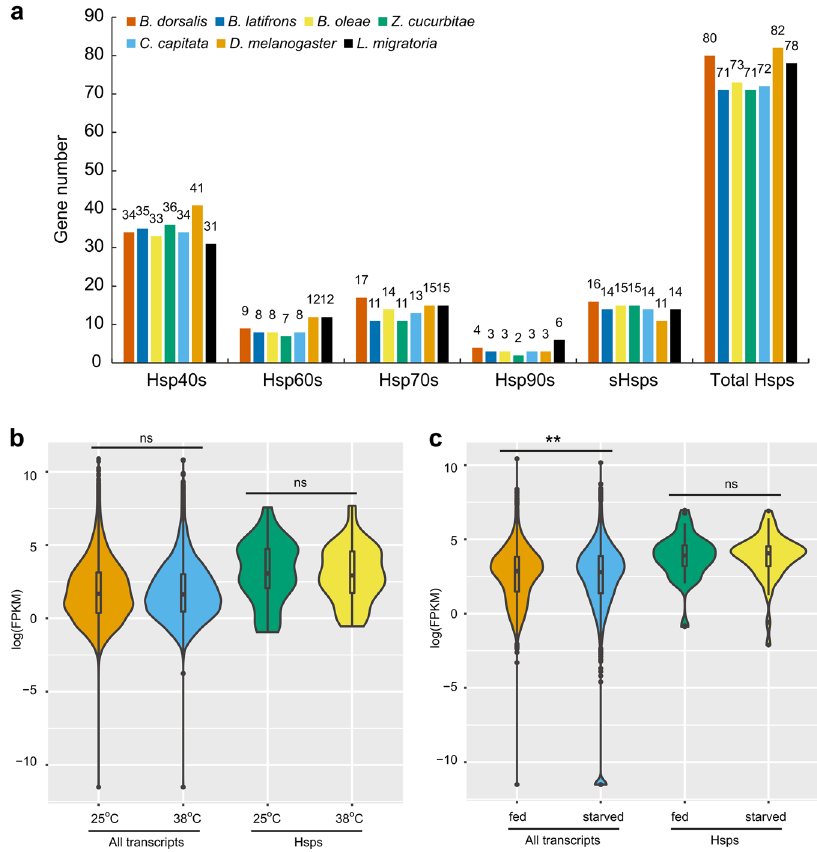
Fig. 3 Genome and transcriptome analyses of the Hsp gene family in Bactrocera dorsalis . a Comparison of gene numbers for Hsp40, Hsp60, Hsp70, Hsp90, sHsps, and total Hsps in B. dorsalis , B. latifrons , B. oleae , Z. cucurbitae , C. capitata , D. melanogaster , and L. migratoria . b Comparison of all transcripts and Hsp transcripts under high-temperature (25 vs 38 °C). c Comparison of all transcripts and Hsp transcripts under starvation conditions (fed vs